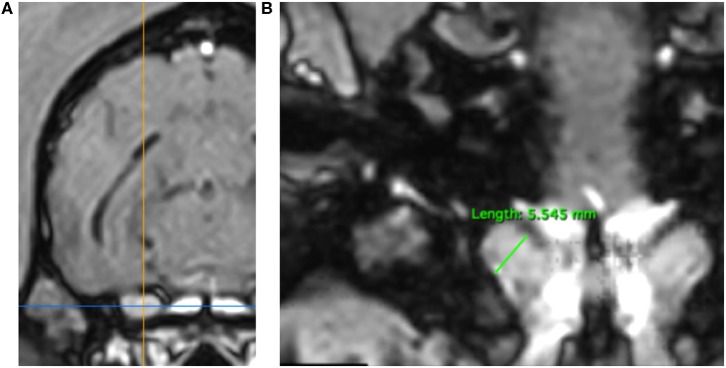
MPR of a 3DT1+C sequence of the brain of a Springer Spaniel (TR = 20.2 ms, TE = 10.3 ms, ST = 1 mm). Transverse reconstruction (A). The intersection of the saggital axis (yellow line) and dorsal axis (blue line) is centered over each trigeminal nerve in turn. Dorsal reconstruction (B). The trigeminal nerve is identified coursing craniolaterally over the wings of the basisphenoid bone. Caliper measurement of TDW (green line) for calculation of WBR. TDW, trigeminal nerve dorsal width; WBR, width-to-brain ratio.